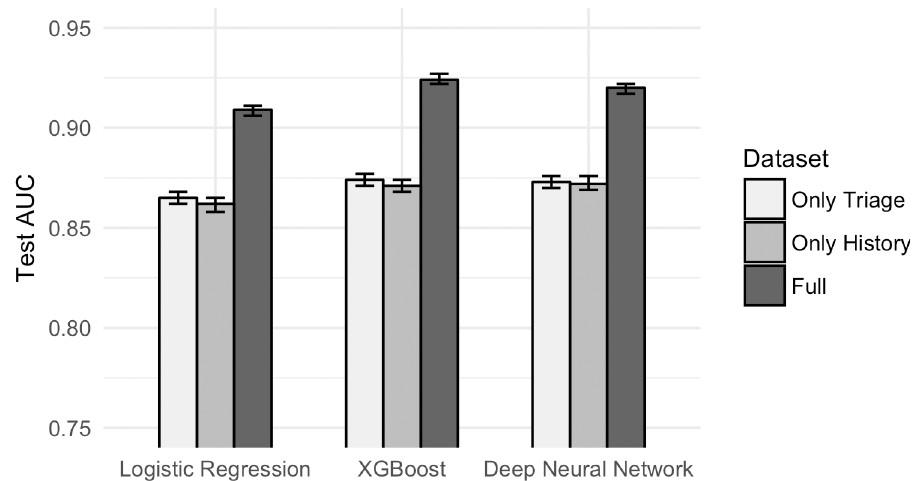
Fig 1. Test AUC by dataset type by algorithm. Addition of historical information improves predictive performance significantly compared to using triage information alone. Patient history alone can predict admission to a reasonable degree.